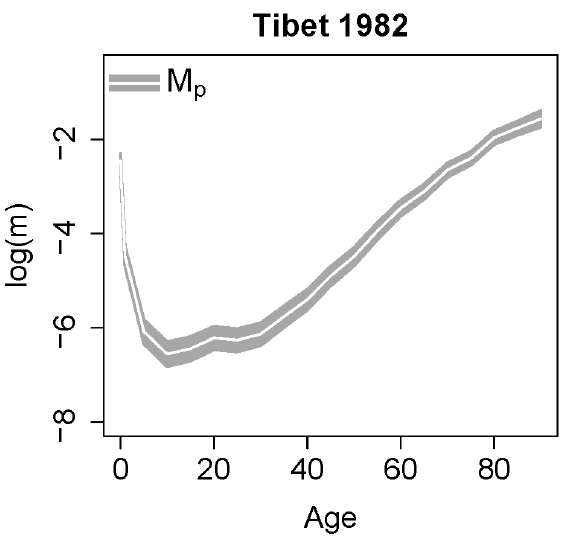
Figure 4. Estimated mortality rates for Tibet in 1982.